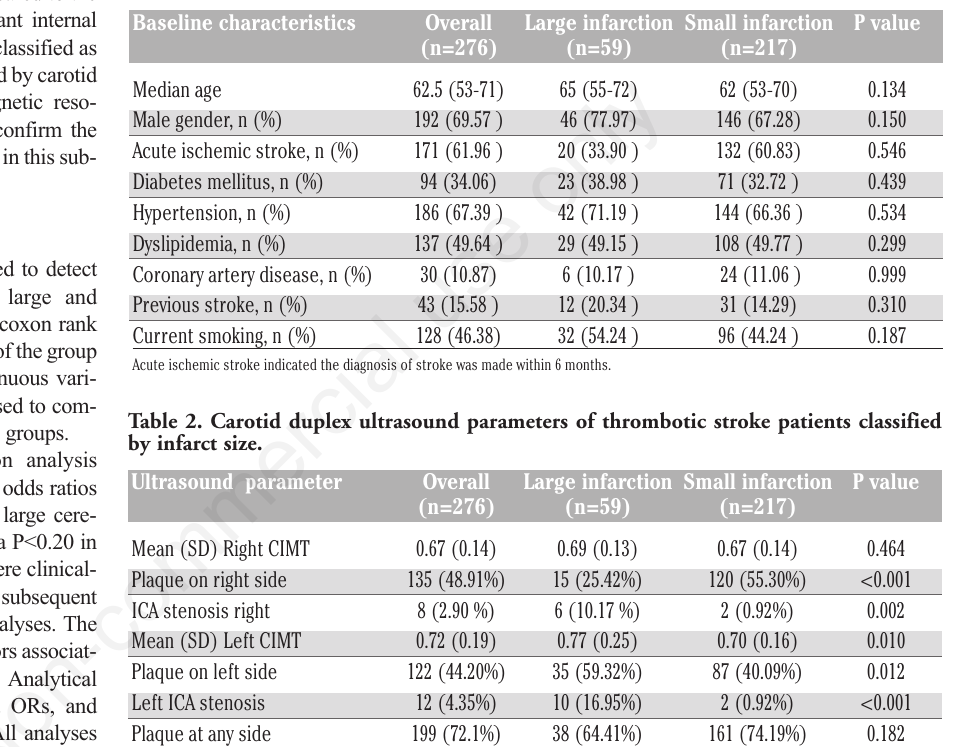
Table 1. Baseline characteristics of thrombotic stroke patients classified by infarct size.